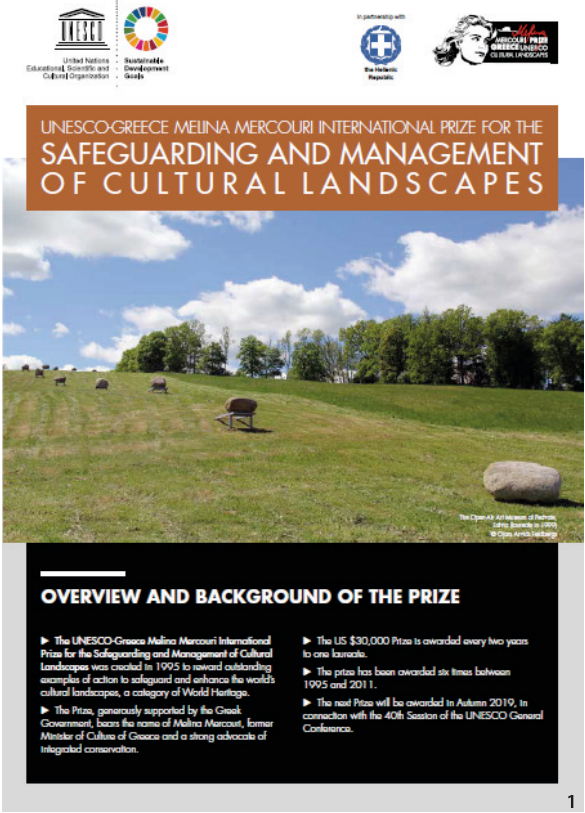
Figure 1 Cover page of the promotional brochure of the UNESCO- Greece Melina Mercouri International Prize for the Safeguarding and Management of Cultural Landscapes (Source: